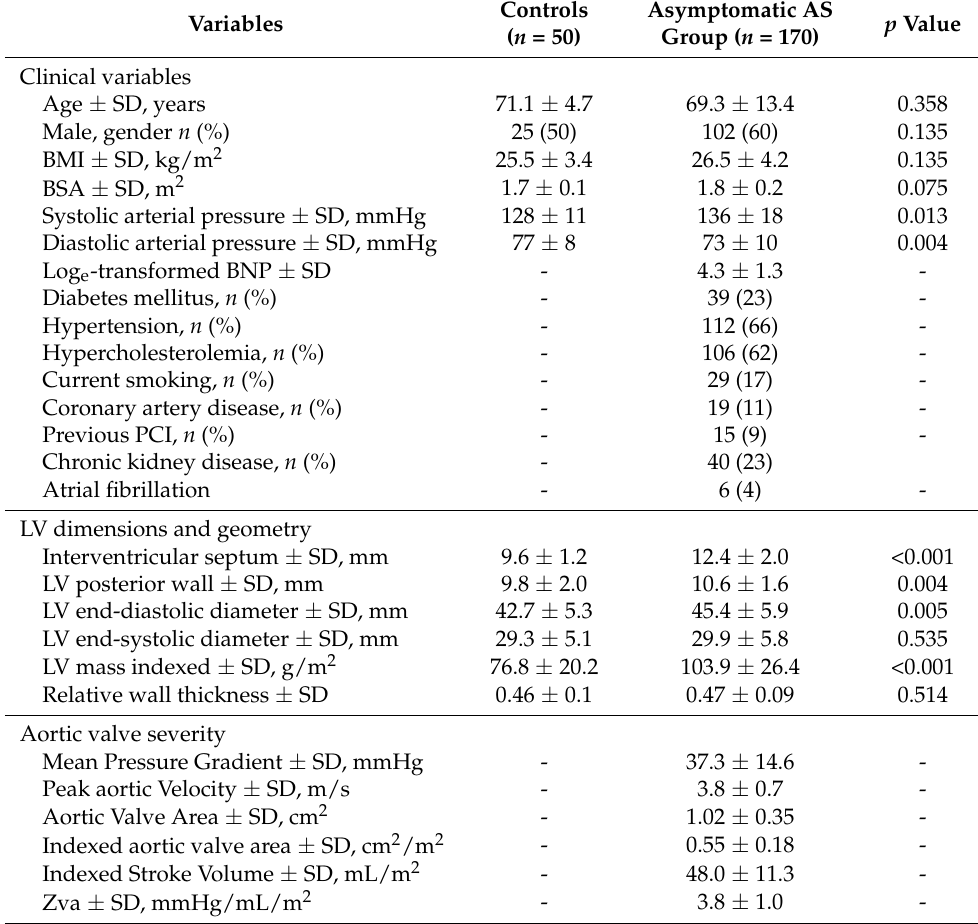
Table 1. Baseline clinical and echocardiographic characteristics. Variables